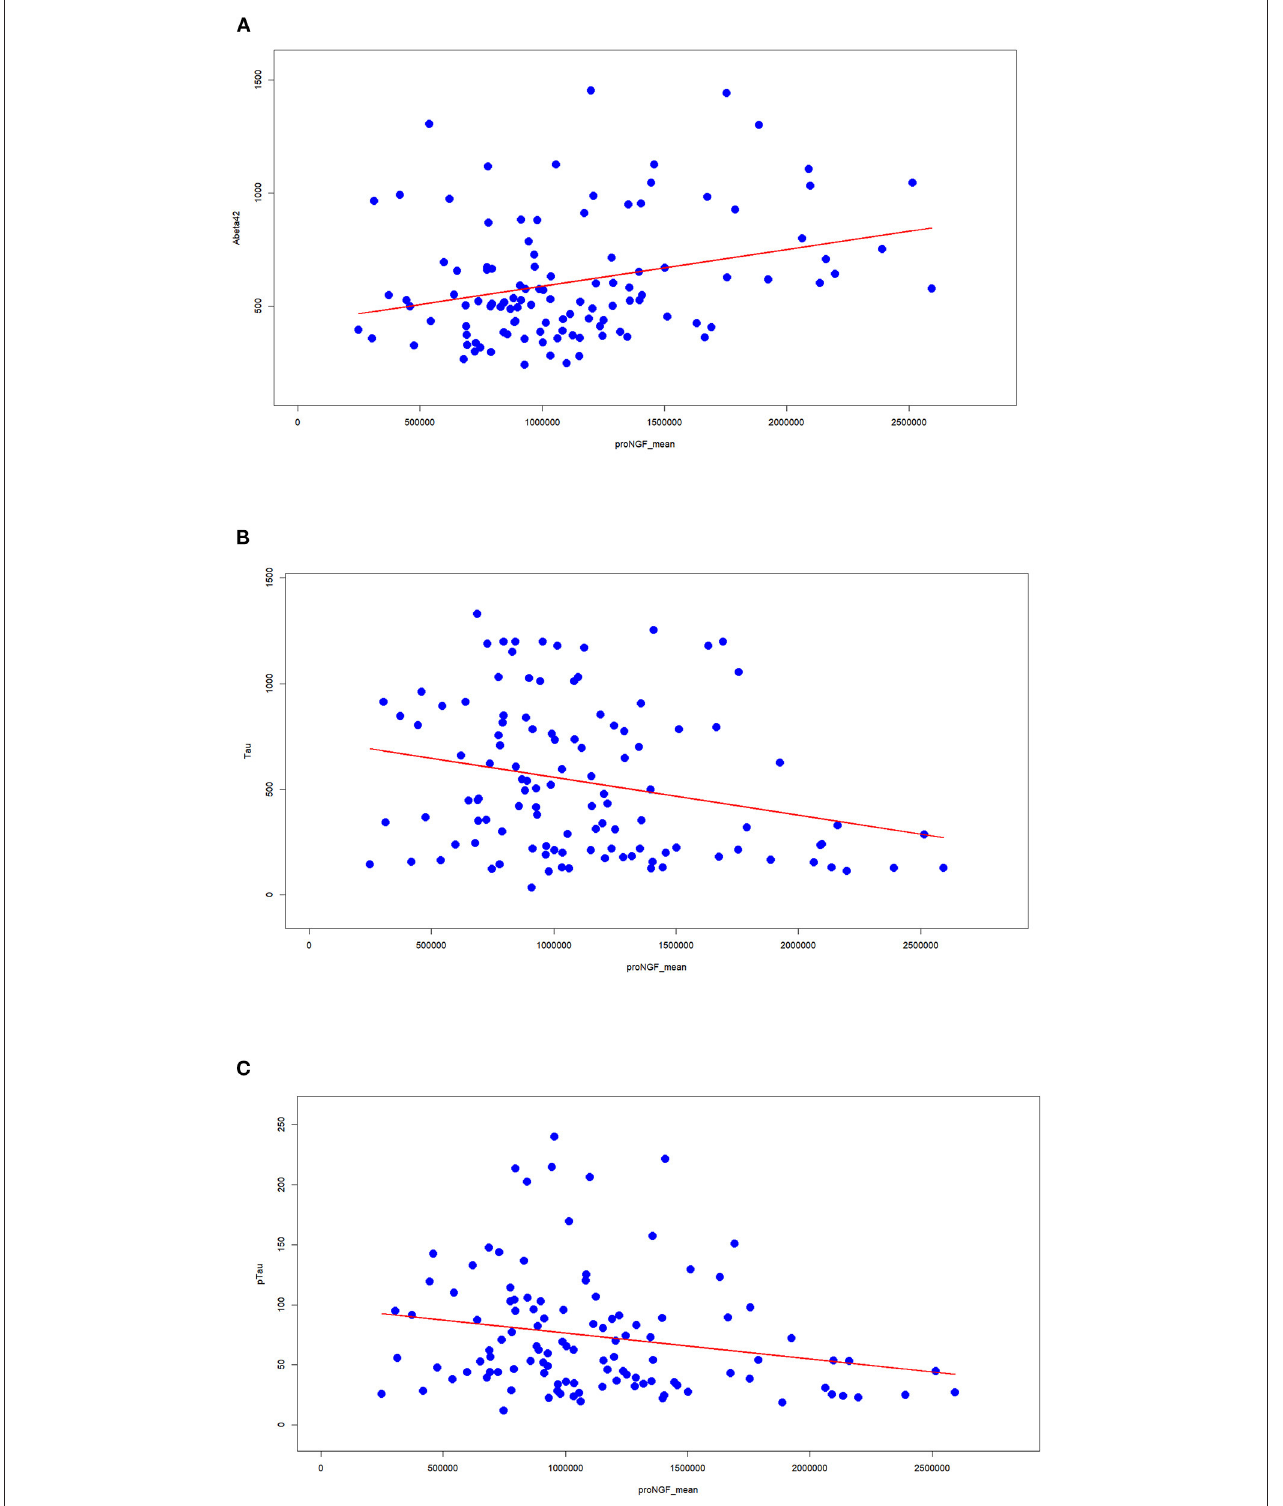
FIGURE 3 | Correlation between proNGF and the clinically validated biomarkers. The Spearman’s index and the corresponding statistical significance are computed between proNGF levels (peak area) and the three classical AD biomarkers [ (A) A β 42; (B) tau; (C) pTau].